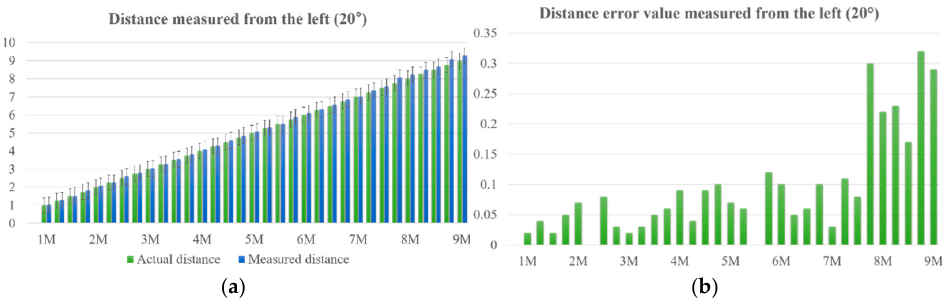
Figure 8. ( a ) Distance measured from the left (20°), ( b ) distance error value measured from the left (20°).